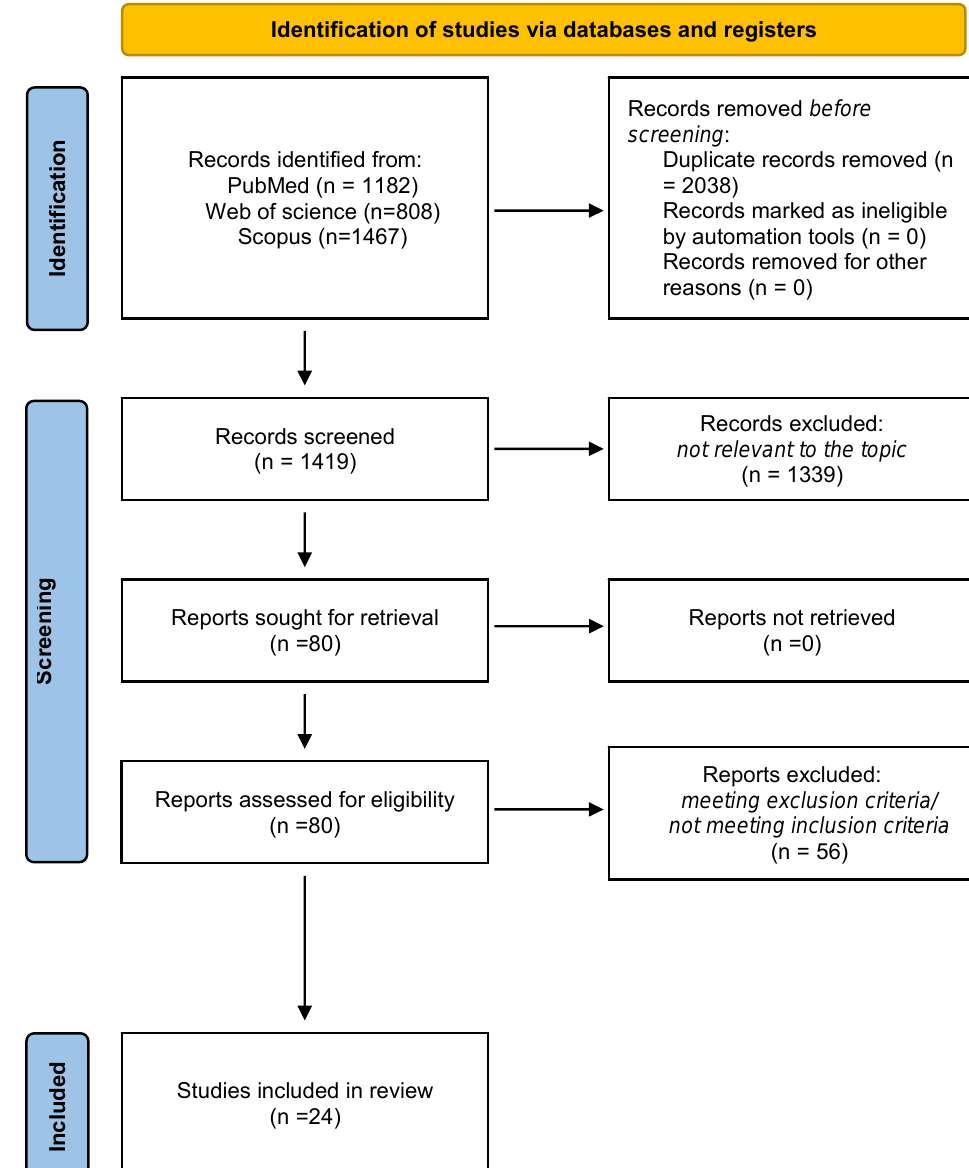
Figure 1. PRISMA flow diagram summarizing the literature review and inclusion/exclusion process.